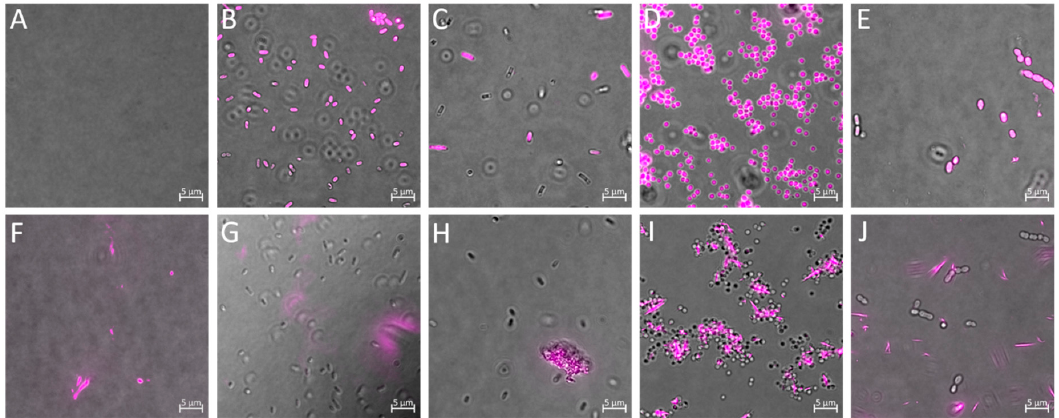
Figure 5. Fluorescence and brightfield overlay micrographs of bacterial cells treated with FN 14 or FM 17 . ( A ) Medium (0.9% NaCl) containing FN 14 (600 µM); ( B ) FN 14 (600 µM) and P. aeruginosa ; 17 . ( A ) Medium (0.9% NaCl) containing FN 14 (600 µ M); ( B ) FN 14 (600 µ M) and P. aeruginosa ; ( C ) FN ( C ) FN 14 (600 µM) and E. coli ; ( D ) FN 14 (150 µM) and S. aureus ; ( E ) FN 14 (150 µM) and E. faecalis 14 (600 µ M) and E. coli ; ( D ) FN 14 (150 µ M) and S. aureus ; ( E ) FN 14 (150 µ M) and E. faecalis cells; ( F ) cells; ( F ) Medium (0.9% NaCl) containing FM 17 (600 µM); ( G ) FM 17 (600 µM) and P. aeruginosa ; ( H ) Medium (0.9% NaCl) containing FM 17 (600 µ M); ( G ) FM 17 (600 µ M) and P. aeruginosa ; ( H ) FM 17 (600 FM 17 (600 µM) and E. coli ; ( I ) FM 17 (600 µM) and S. aureus ; ( J ) FM 17 (600 µM) and E. faecalis . Scale µ M) and E. coli ; ( I ) FM 17 (600 µ M) and S. aureus ; ( J ) FM 17 (600 µ M) and E. faecalis . Scale bars are 5 µ bars are 5 µM in length.